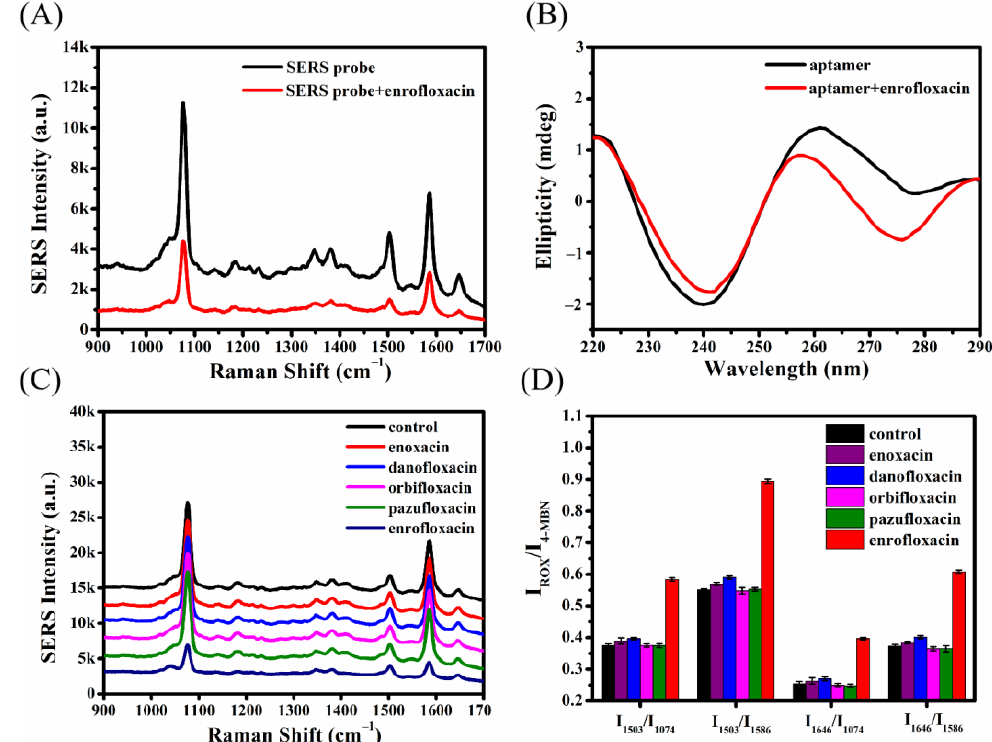
Figure 2. Results of the feasibility of detecting enrofloxacin using the proposed ratiometric SERS aptasensor. ( A ) SERS spectra of the probes before and after binding with enrofloxacin. ( B ) CD spectra of aptamer in the absence and presence of enrofloxacin. ( C ) SERS spectra of the probes incubated with enoxacin, danofloxacin, orbifloxacin, pazufloxacin and enrofloxacin at the concentration of 1 µ M. ( D ) Ratios of the SERS signal intensities of ROX (I ROX ) to 4-MBN (I 4-MBN ).